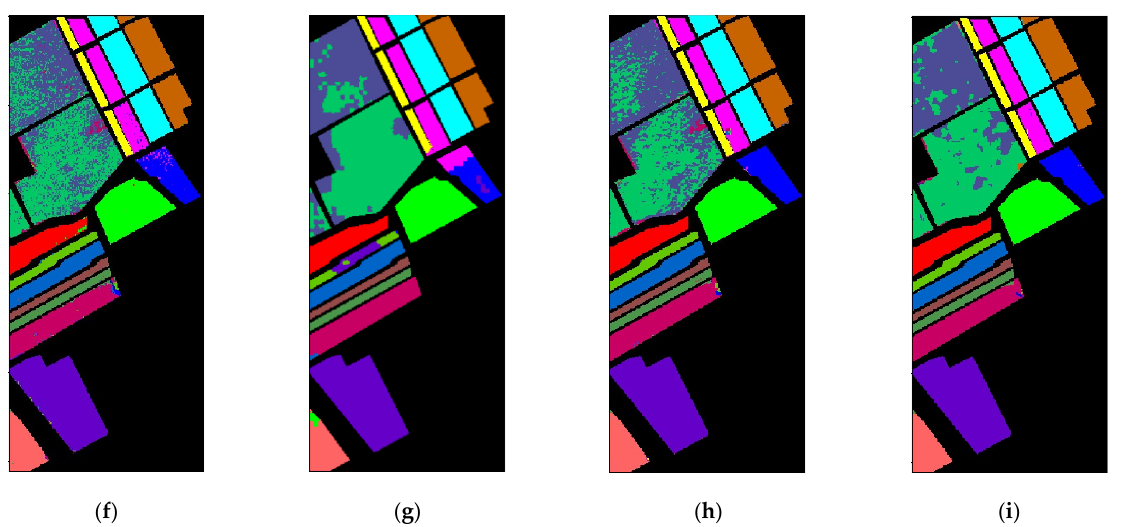
Figure 10. Classification map of various algorithms in the Salinas data set (( a ) Gound-truth map; ( b ) KNN; ( c ) SVM; ( d ) 2D-CNN; ( e ) CNN-PPF; ( f ) miniGCN; ( g ) MDGCN; ( h ) FuNet-C; ( i ) SSOGCN).